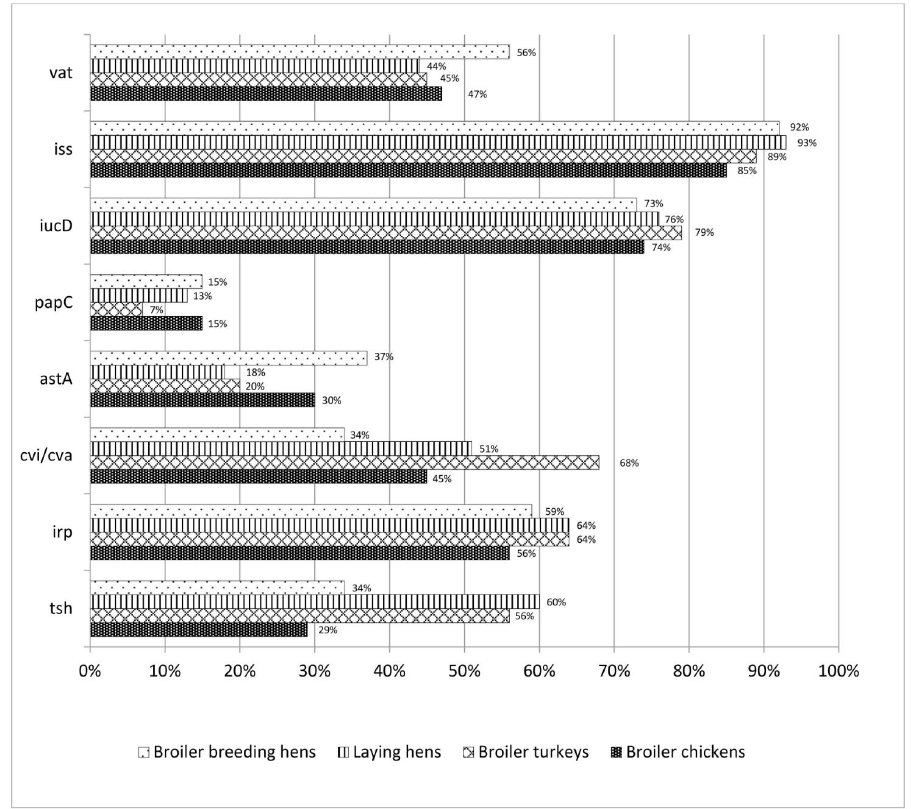
Figure 1. Prevalence of individual virulence genes among E. coli strains depending on the species and utility type of poultry.